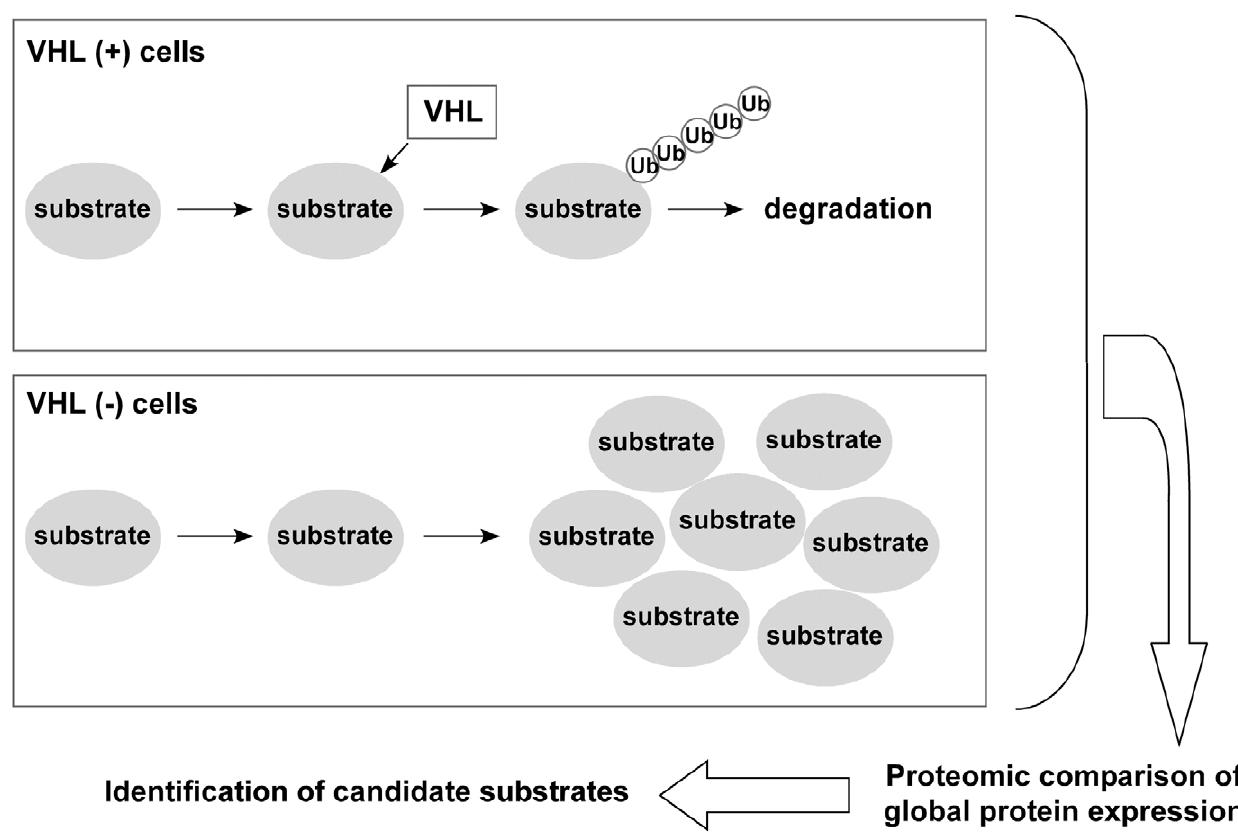
Figure 1. Outline of proteomic screen for VHL substrates. In cells with functional VHL, VHL( + ), VHL substrates are ubiquitinated and degraded by the proteasome. In cells without functional VHL, VHL(-), VHL substrates accumulate. By comparing the global protein expression of VHL( + ) and VHL(-) cells by quantitative proteomics, candidate VHL substrates can be identified.